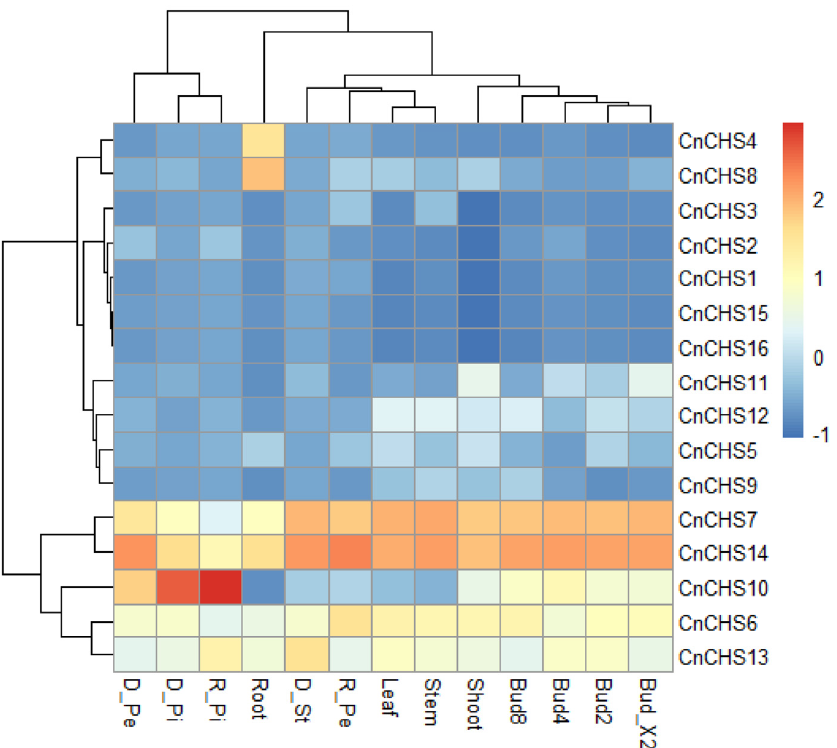
Figure 6. Profiles of expression of the CnCHS genes in all vegetative tissues, various flower organs, and flower buds of different stages of chrysanthemum ‘Jinba.’ There were three replicates per sample Log2-transformed average FPKM values, as per the standardization, were used to plot the heatmap. Red indicates high expression, and green indicates low expression. Bud2, 4, 8, and Bud_X2: flower buds of different stages. D_St: disc floret stamen; D_Pe: disc floret petal; D_Pi: disc floret pistil; R_Pe: ray floret petal; R_Pi: ray floret pistil.